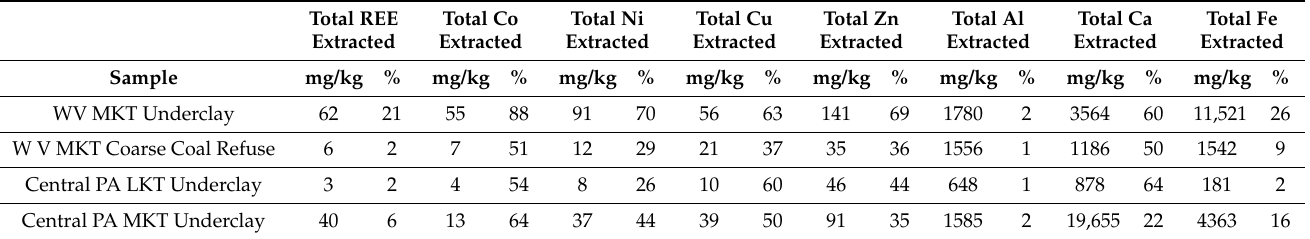
Table 5. Total amount extracted (mg element extracted per kg underclay) and percentage (%) of REEs and elements of interest from the bulk compositions of coal-related samples.